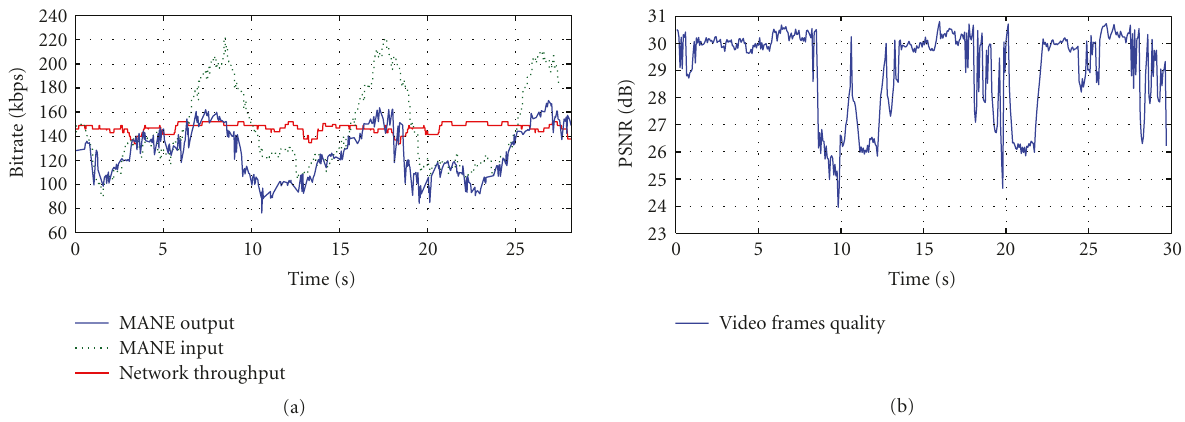
Figure 10: Bitrate adaptation with highly variable source bitrate (Stefan, BLER = 3 . 3%, tti = 4milliseconds).